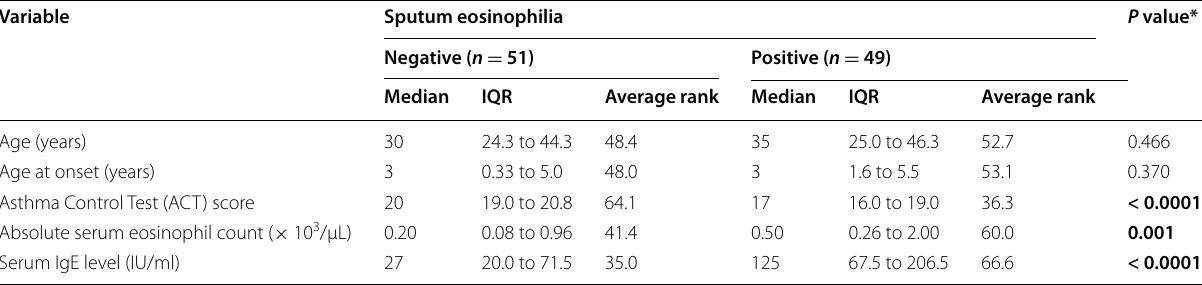
Data are median and interquartile range (IQR)